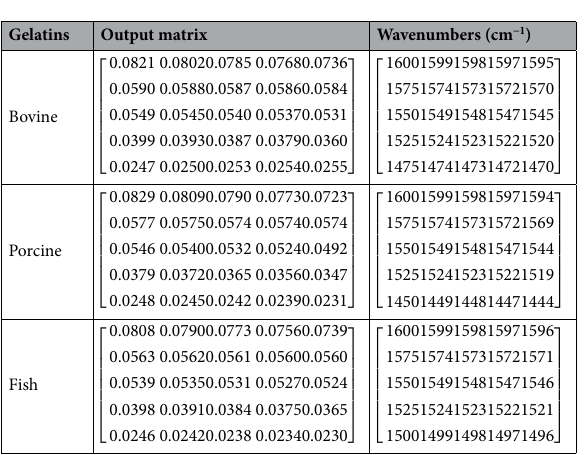
Table 2. Dominant output matrices with respective wavenumbers regions for bovine, porcine and fish gelatin spectra in 1600–1000 cm −1 region.